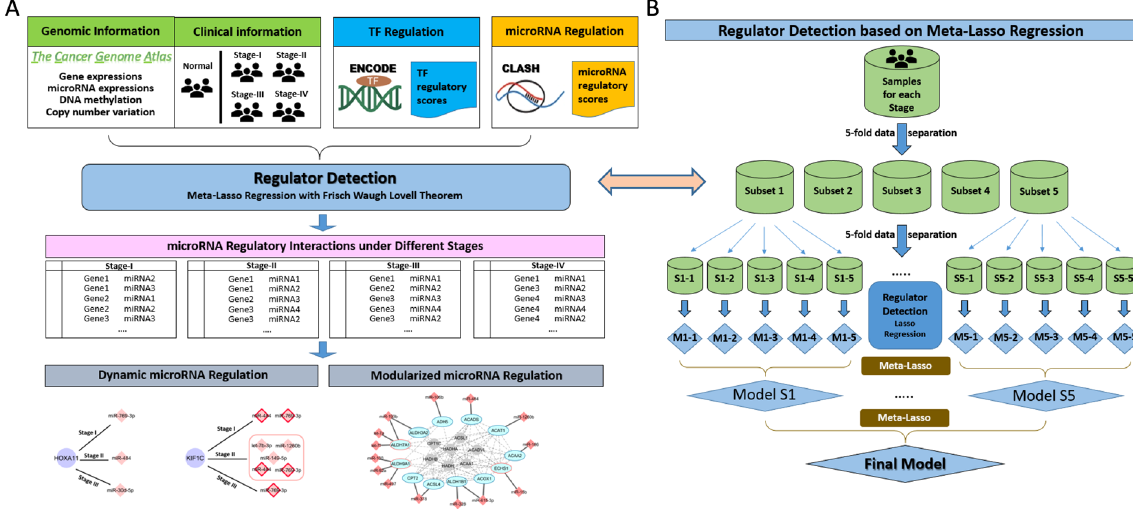
Figure 1. Discovery of dynamic and modularized miRNA regulation during cancer progression. ( A ) The identification pipeline of conditional miRNA regulatory interactions; ( B ) Meta-Lasso Regression approach to the detection of microRNA regulators of each gene in each cancer